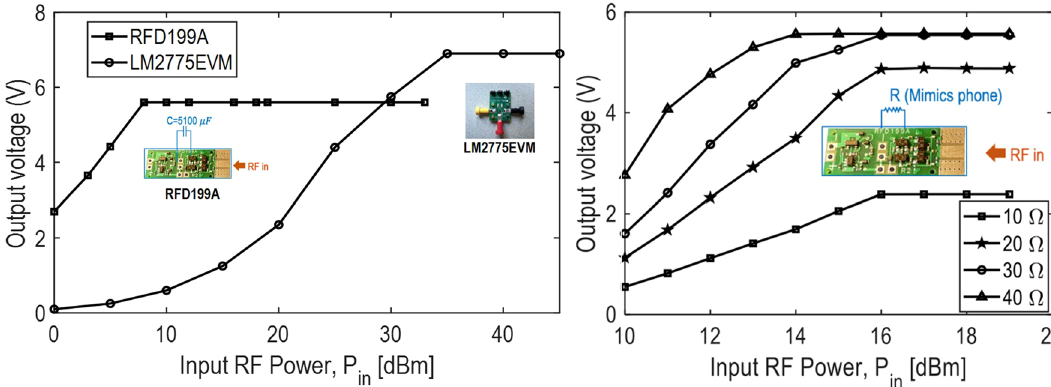
Figure 5. Comparison of the chosen rectifier + power management topologies for the proposed receiver system. Plot generated using Matlab R2019b available at https:// mathw orks. com.